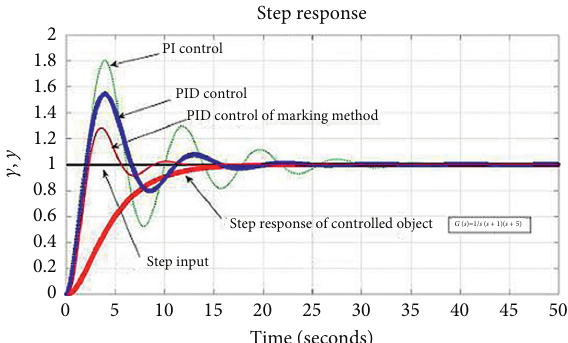
Figure 20: Comparison of control effects.